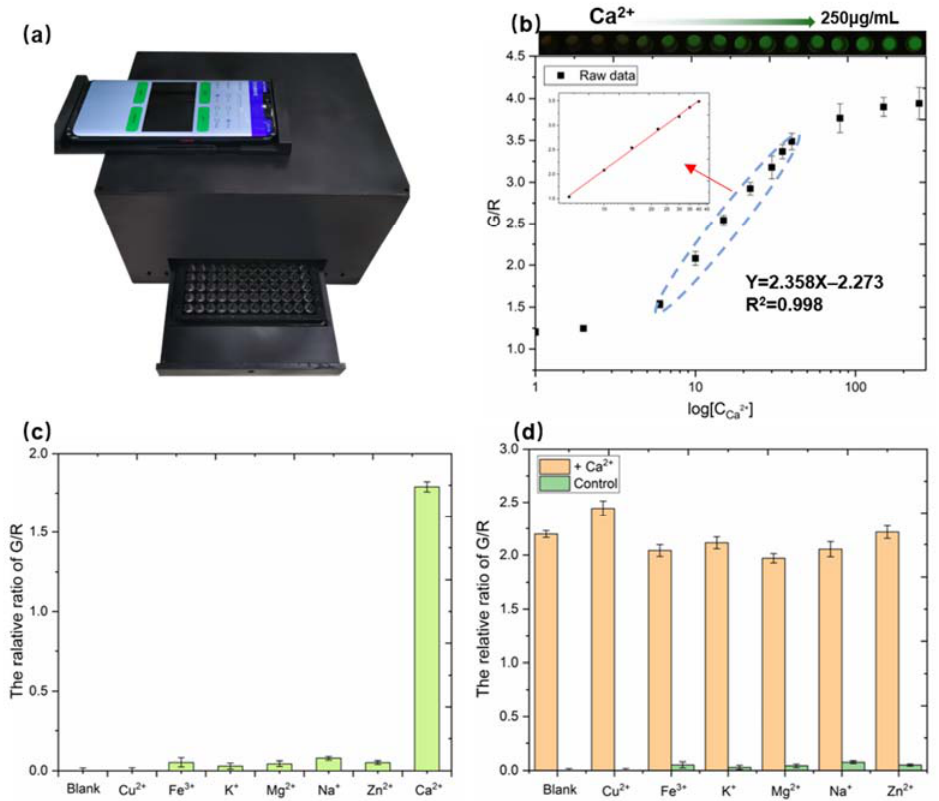
Figure 5. ( a ) The samples of different Ca 2+ concentrations were tested by the SRFP platform. ( b ) The relationship results between the G/B value and the different concentrations of Ca 2+ . ( c ) Selectivity of the fluorescence ratiometric probes for detecting Ca 2+ (25 μ M) and interfering substances (Cu 2+ , Fe 3+ , K + , Mg 2+ , Na + , Zn 2+ ). ( d ) The relative value ratio is Green /Red of the mixed with different interfering substances (Cu 2+ , Fe 3+ , K + , Mg 2+ , Na + , Zn 2+ ). Tests were performed in triplicate. Error bar indicates mean ± standard deviation for three measurements at different places. Table 1. Comparison of SRFP performance with other reported sensors for Ca 2+